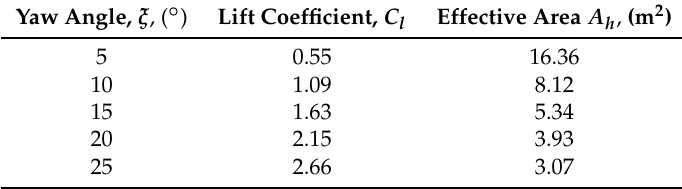
Table 4. Effective area required for a plate tail fin at different yawing angles, l = 50 m, ρ = 1030 kg/m 2 , U = 1.4